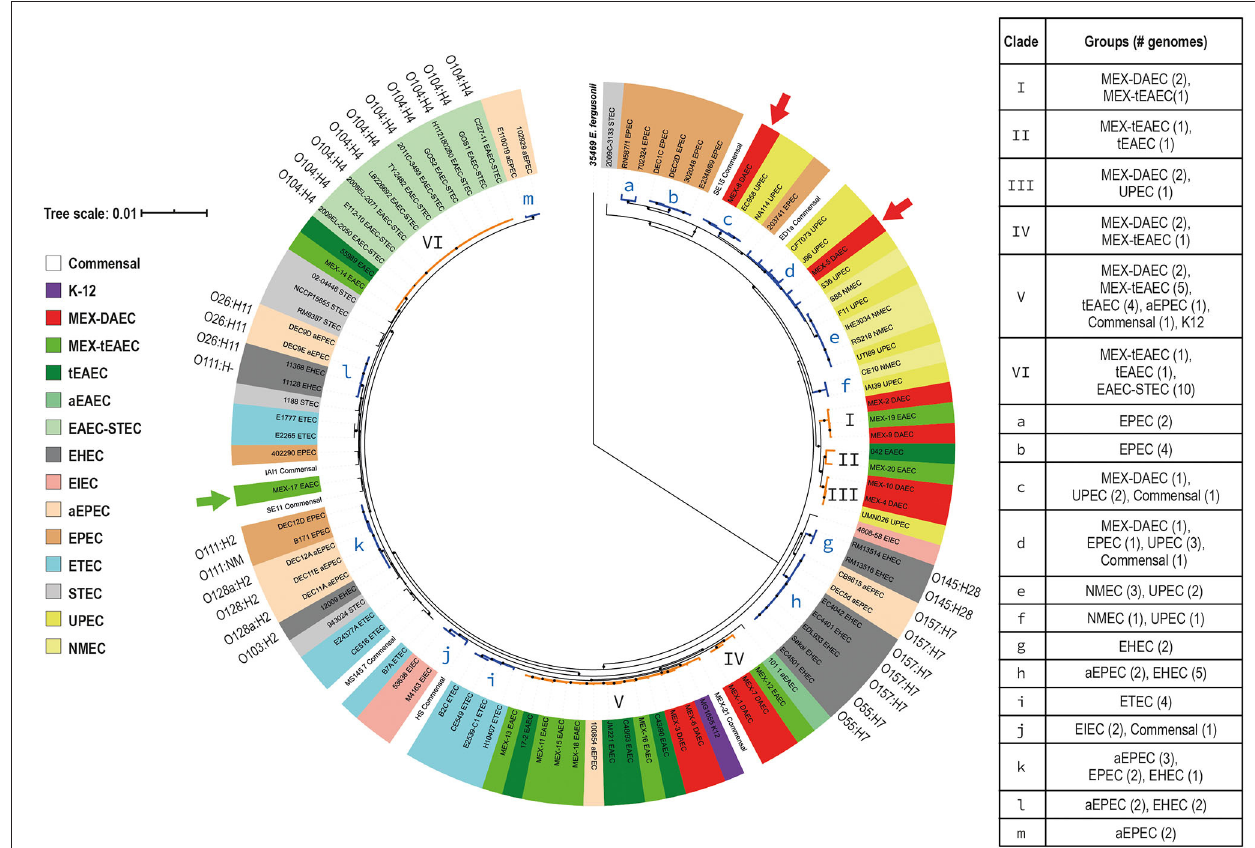
FIGURE 2 | Core-genome (GTR + F + R10) phylogenetic tree. A maximum likelihood tree was constructed based on 1,144 single copy genes from the E. coli core-genome. E. fergusonii 35,469 (in bold) was used as an out-group. The tree was then calculated by IQtree v1.6.12 (Minh et al., 2020) with 1,000 Bootstrap replicates for internal branch support and values over 70% are indicated at each node with a black circle. Population structure was calculated using a Bayesian approach by RhierBAPS package ( Tonkin-Hill et al., 2018) in R 3.6.3. E. coli groups are indicated by different color labels listed in the left chart. Clades including more than one DAEC or tEAEC genomes are highlighted in orange and the roman numerals in front of them indicate the clade number. Two DAEC (red arrows) and one tEAEC (green arrow) genomes were located outside these clades. Clades highlighted in blue (a–m) contain other pathogenic E. coli genomes that had important associations. The scale bar represents the number of nucleotide substitutions per